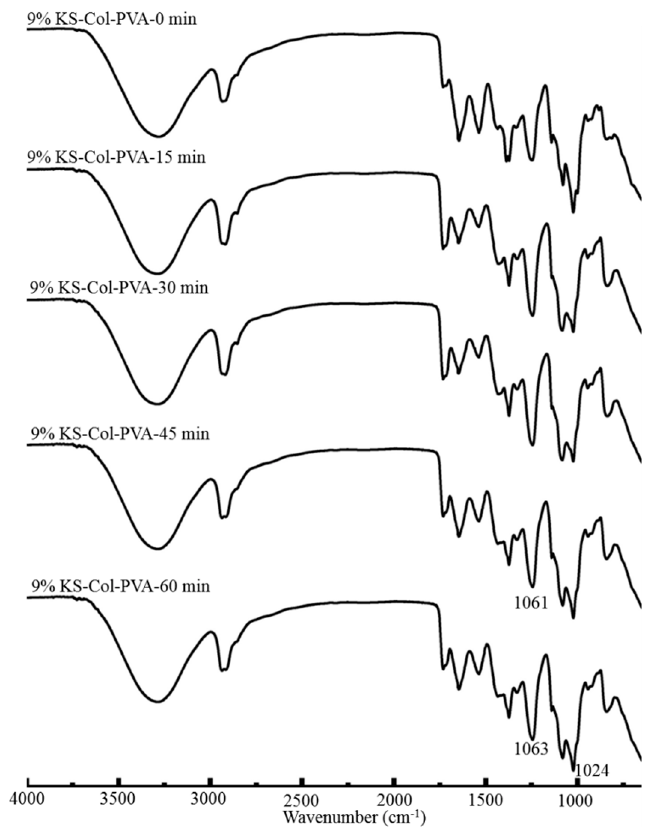
Figure 8. Effect of time of ultrasound treatment of the 9% KS-Col-PVA composite films on FTIR.